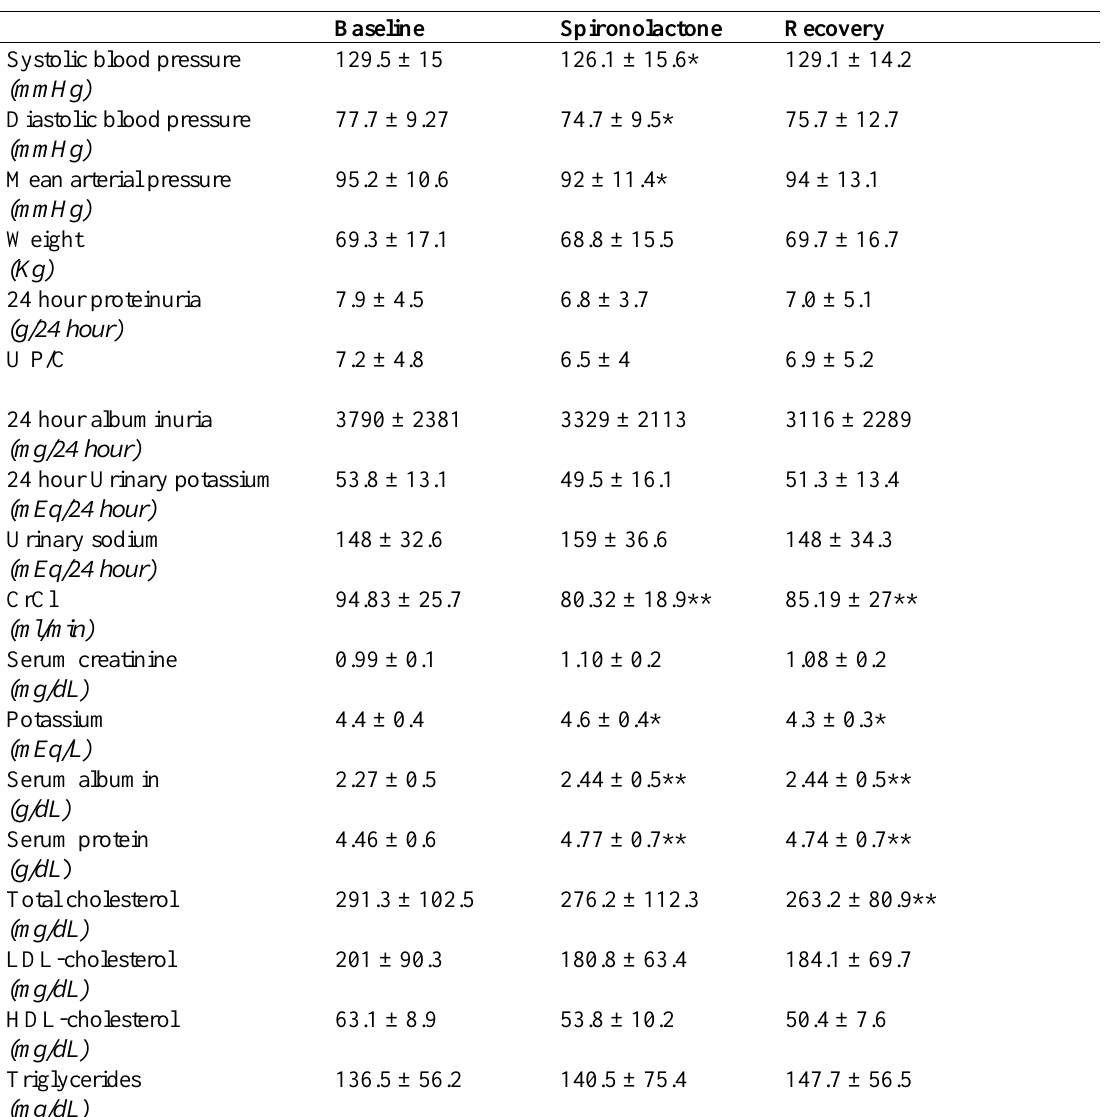
Table 1. Main baseline and outcome